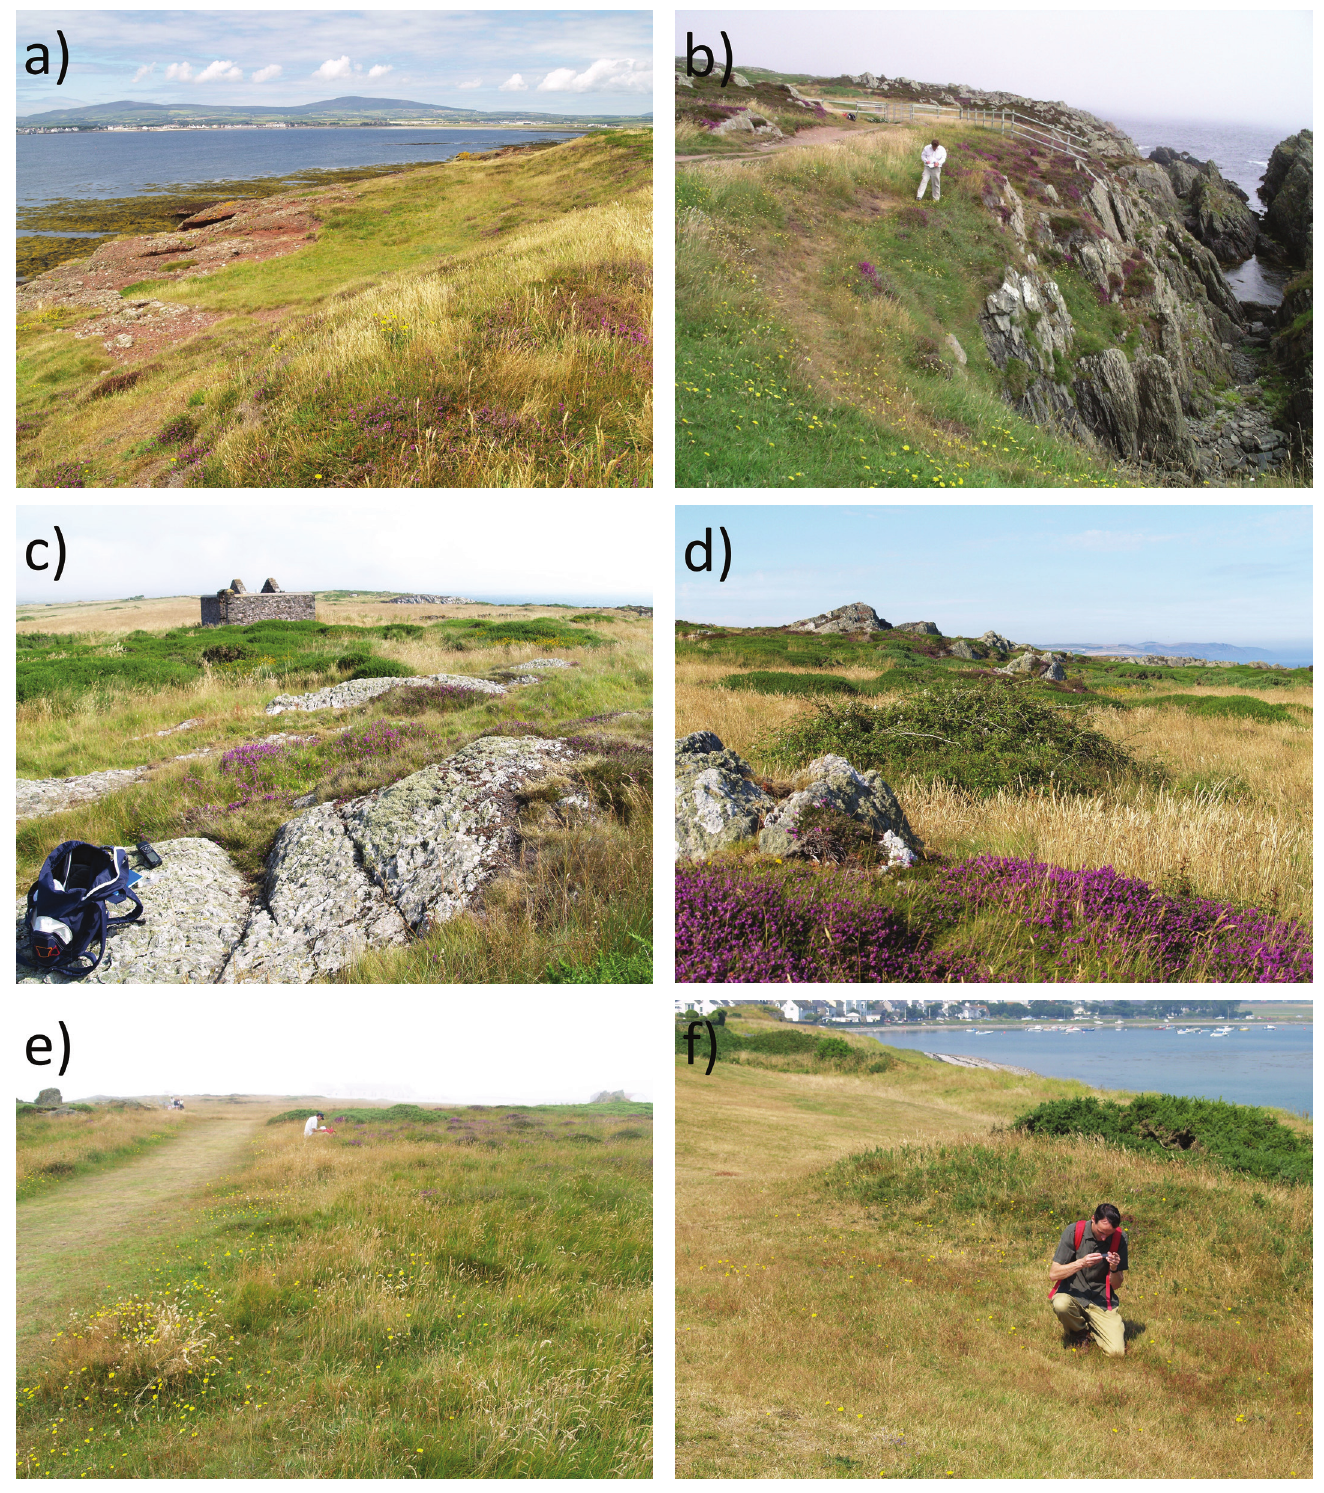
Fig. 1. Langness Peninsula in July 2006: A . and B. Short grassland supporting S. stigmaticus , M. maculatus and C. brunneus around rocky outcrops above the shore (with AJC taking notes); C. short grassy heath supporting S. stigmaticus near the mid-line of the peninsula; D. tall grassland and gorse near the mid-line of the peninsula with scarce S. stigmaticus restricted to short grass close to rocks and C. brunneus throughout; E. a path with S. stigmaticus occurring immediately adjacent and C. brunneus extending into the taller grassland beyond; and F. a patch of semi-rough (with RGS inspecting a grasshopper) and a grassy mound supporting S. stigmaticus and C. brunneus within the golf